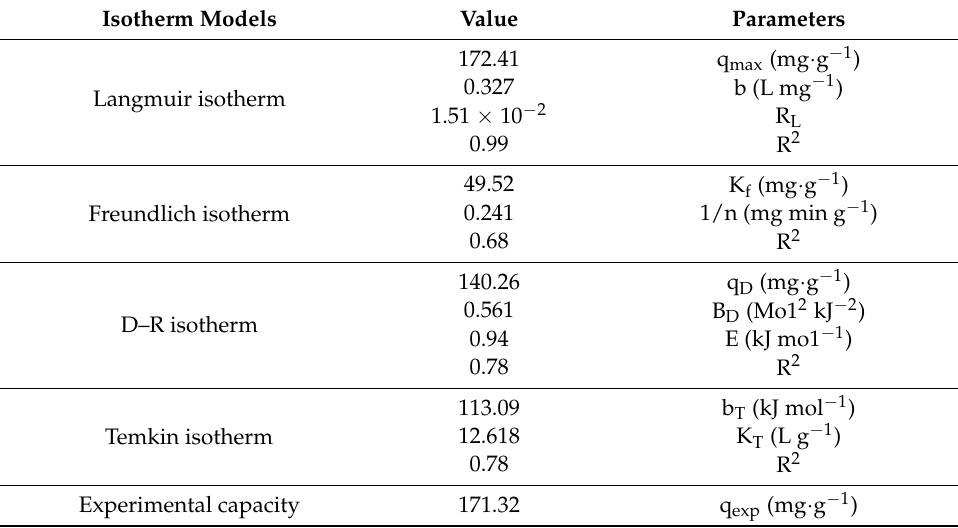
Figure 3. Isotherm models for the adsorption of Y(III) on AHIBC: ( a ) Langmuir isotherm, ( b ) Freun- dlich isotherm, ( c ) Dubinin ‒ Radushkevich isotherm, and ( d ) Temkin isotherm. Table 3. Isotherm models for the Y(III) adsorbed on the AHIBC